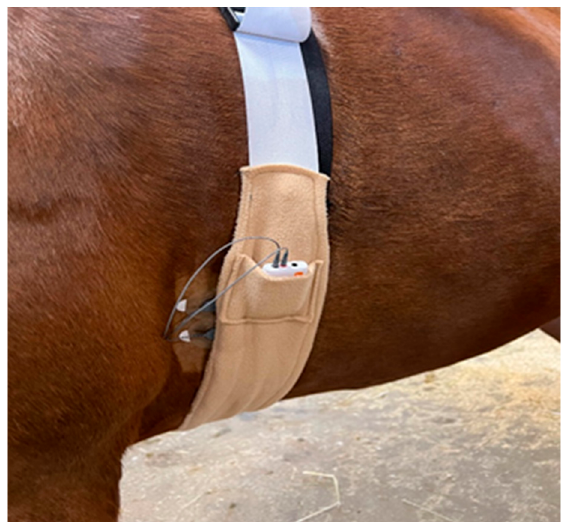
Figure 1. Device placement on the horse’s body.